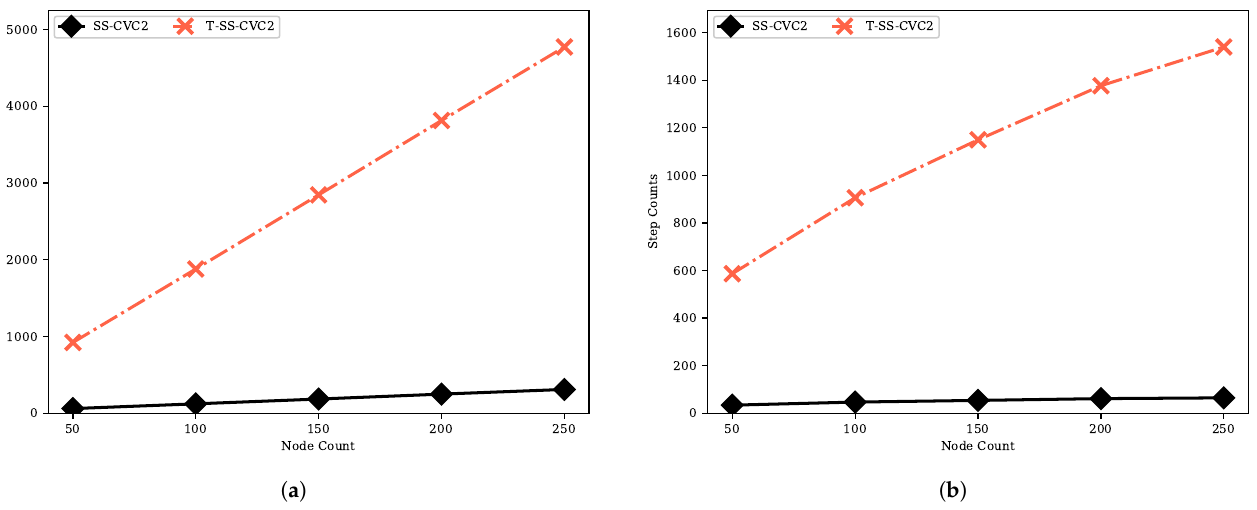
Figure 14. Move and step count performances of T-SS-CVC 2 algorithm against SS-CVC 2 : ( a ) Move count against node count for the fixed average degree 5; ( b ) Step count against node count for the fixed average degree 5.